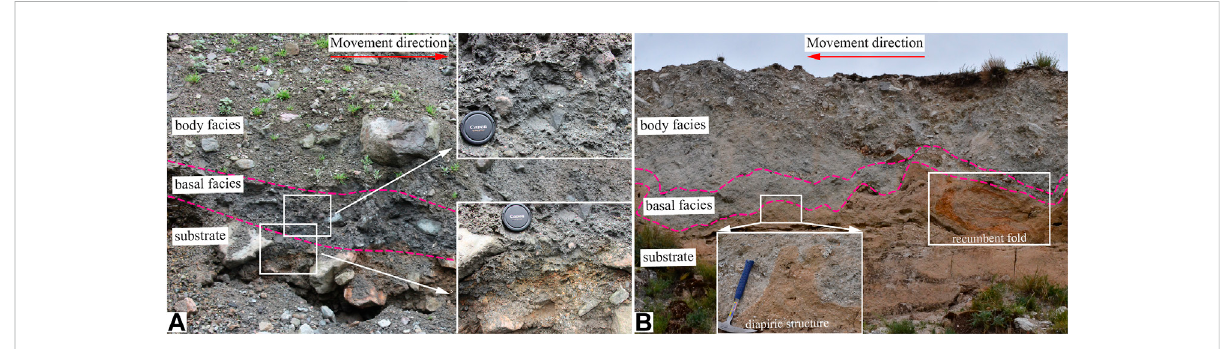
FIGURE 7 Layouts of the basal facies of the Xiejiadianzi (A) and Nyixoi Chongco (B) rock